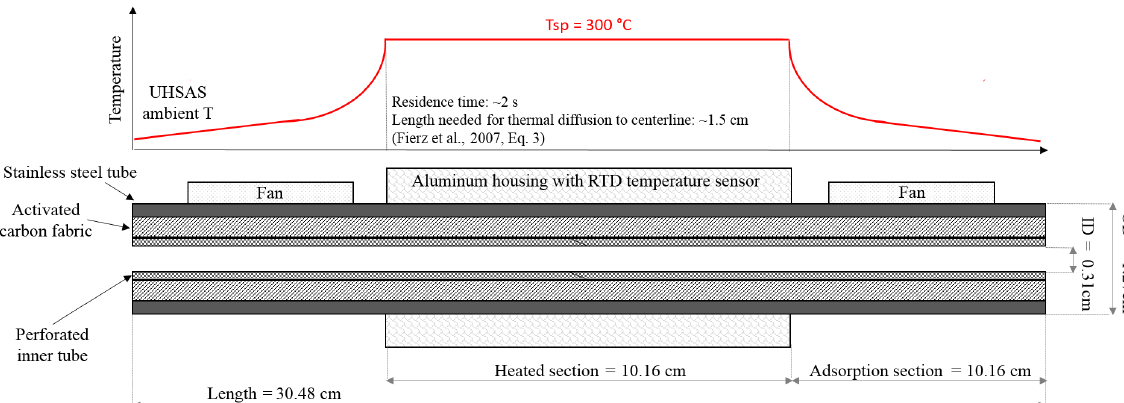
Figure 6. Schematic cross section of the thermodenuder and conceptual temperature profile. Temperature is measured at a single point with a platinum RTD sensor inside the aluminium housing around the heated section. The thermal diffusion length estimate assumes standard pres- sure and temperature and typical flow in the thermodenuder, small perturbations in temperature, and is used only for qualitative understanding of heat flow in the thermodenuder.